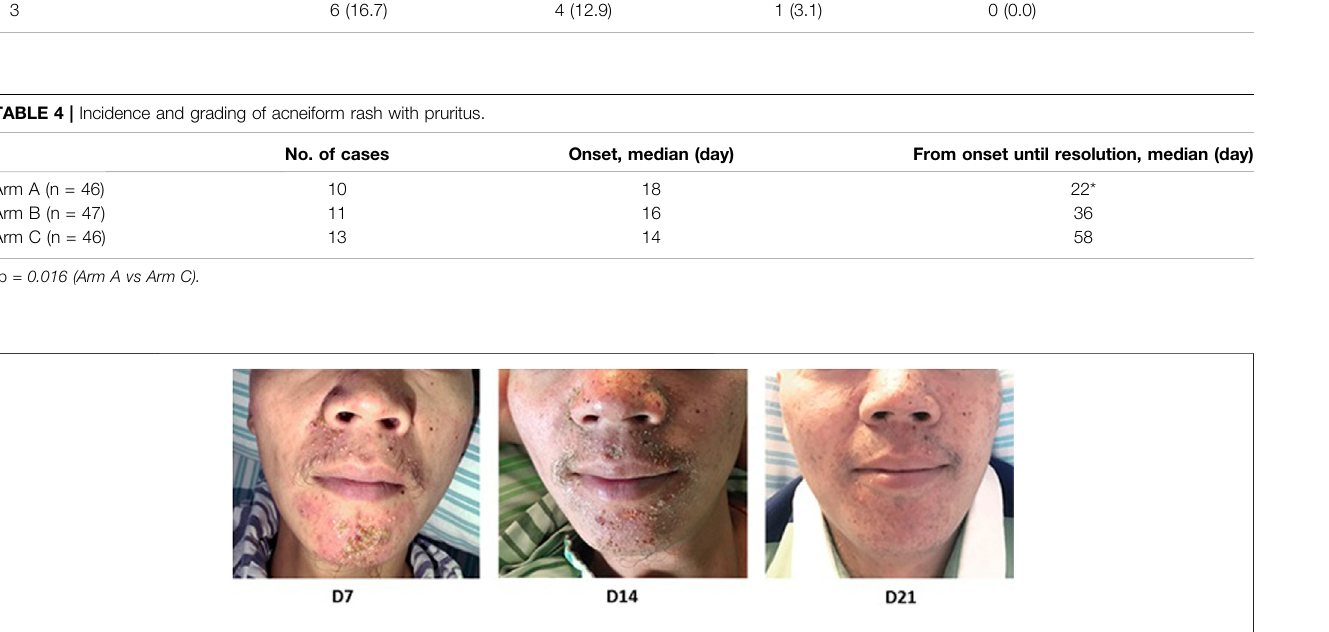
FIGURE 1 | A representative patient in Arm B who recovered from grade 2 acneiform rash by honeysuckle treatment for 3 weeks.